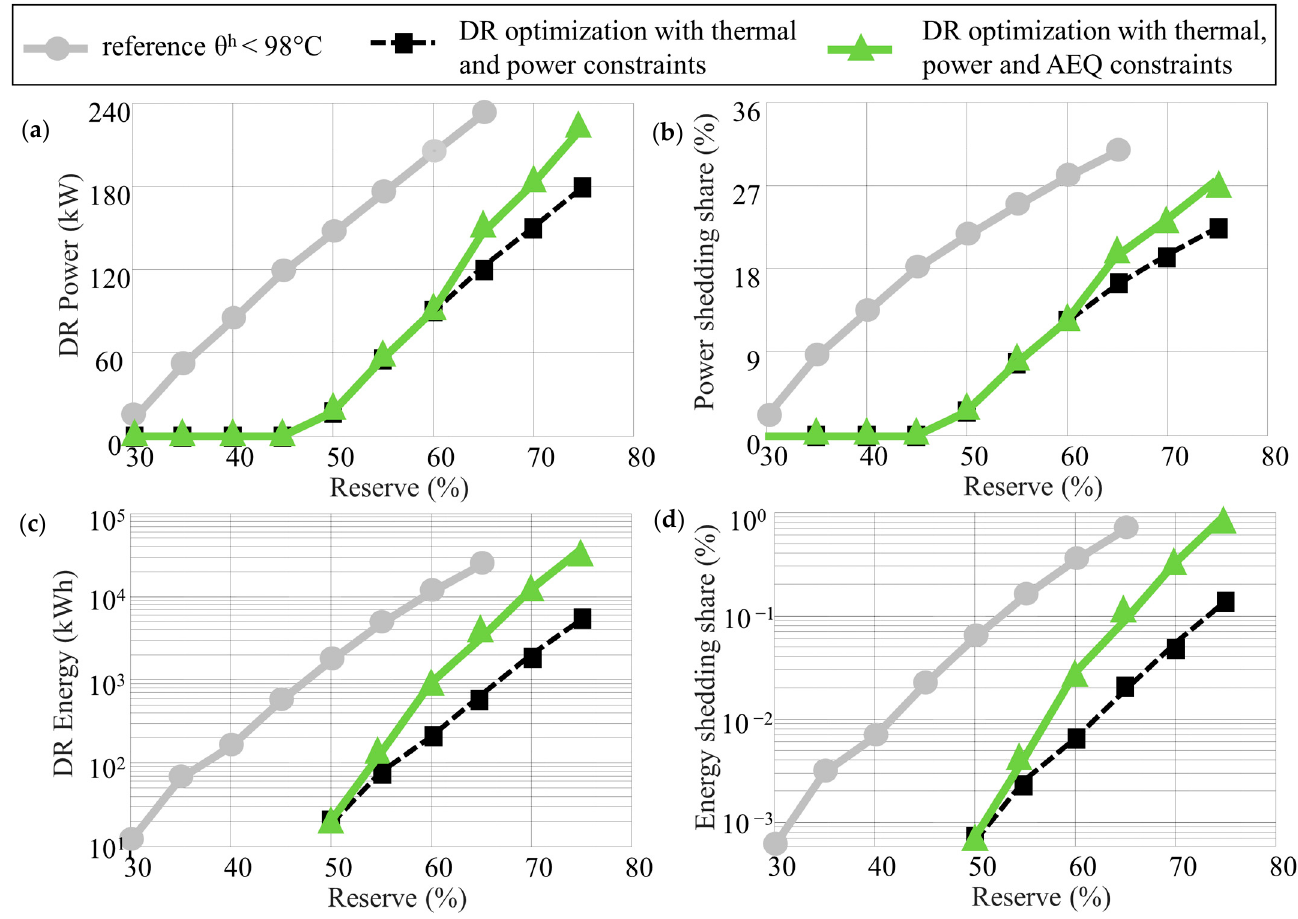
Figure 14. Obtained results for different reserve margins and DR in “energy-shedding” mode: ( a ) DR rated power; ( b ) DR power share compared to the added load; ( c ) DR rated energy; ( d ) DR energy share compared to the total energy of load.